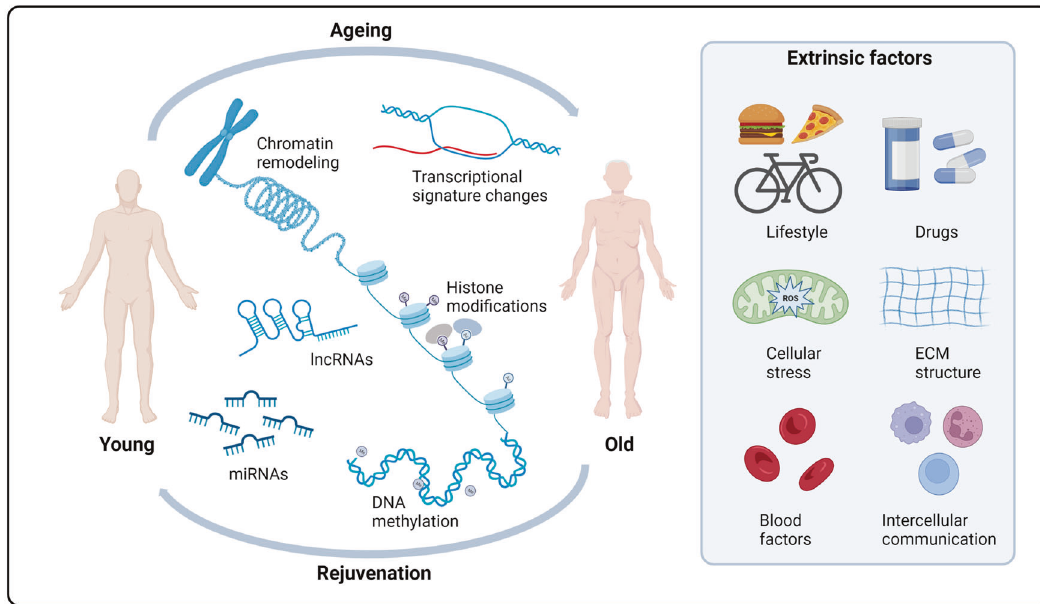
Fig. 2 The epigenetic states of ageing and rejuvenation. Ageing and rejuvenation can be affected by intrinsic epigenetic alterations and genetic instability, like DNA methylation and chromatin remodeling. Moreover, many extrinsic factors, like microenvironmental cues, intercellular communication, and systemic factors, can also impact the epigenetic states of ageing and rejuvenation. miRNAs microRNAs, lncRNAs long noncoding RNAs, ECM extracellular matrix. Created with